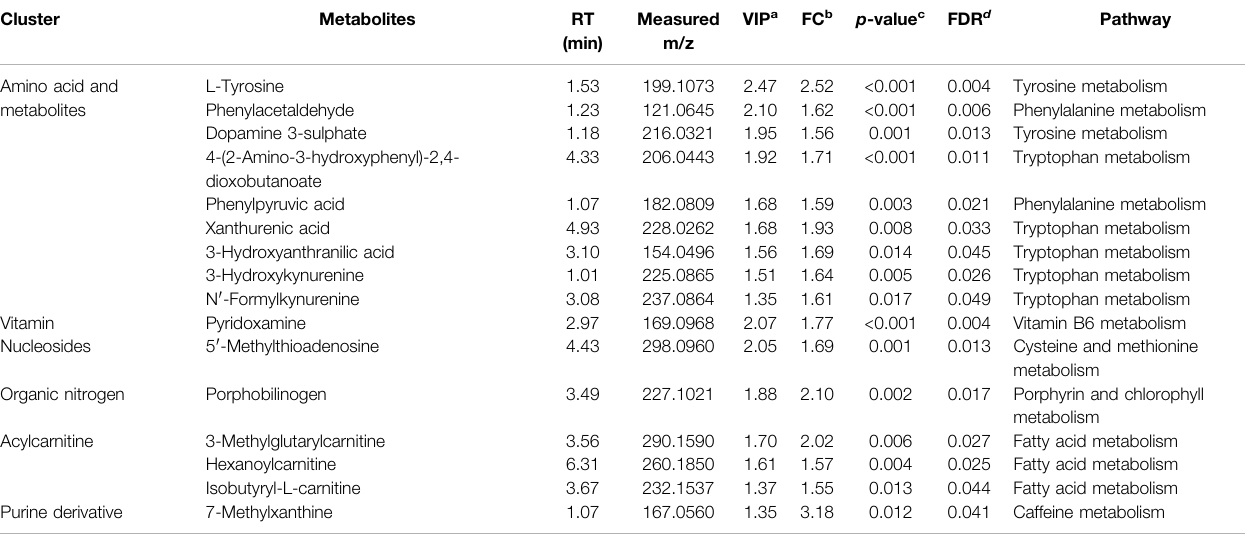
TABLE 2 | Potential biomarkers of urine samples from postoperative emergence agitation (EA) and non-EA patients.